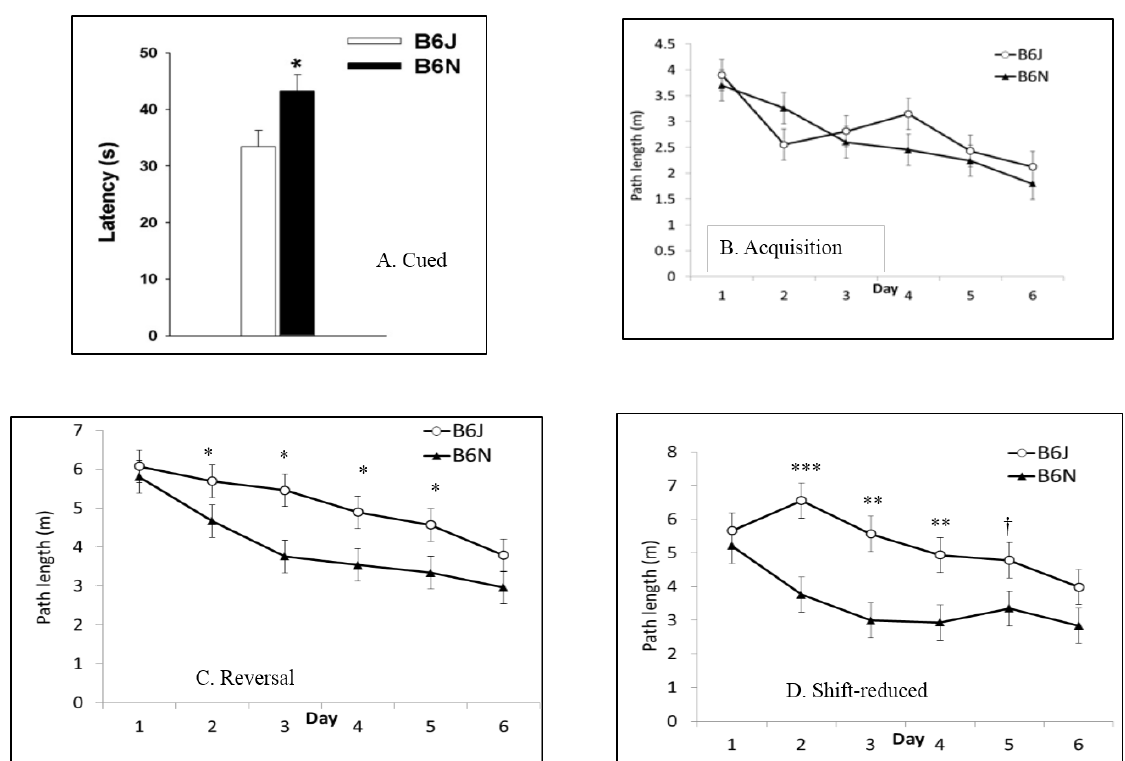
Figure 6. ( A – D ) Morris water maze: females. B6J females had significantly shorter latencies to finding the platform on Day 1 of the cued phase ( p < 0.05). Path lengths were significantly different on Days 2–5 of the reversal phase and Days 2–4 of the shift-reduced phase with a trend on Day 5. † p < 0.1, * p < 0.05, ** p < 0.01, *** p < 0.001. Data are the least square means ± S.E.M.